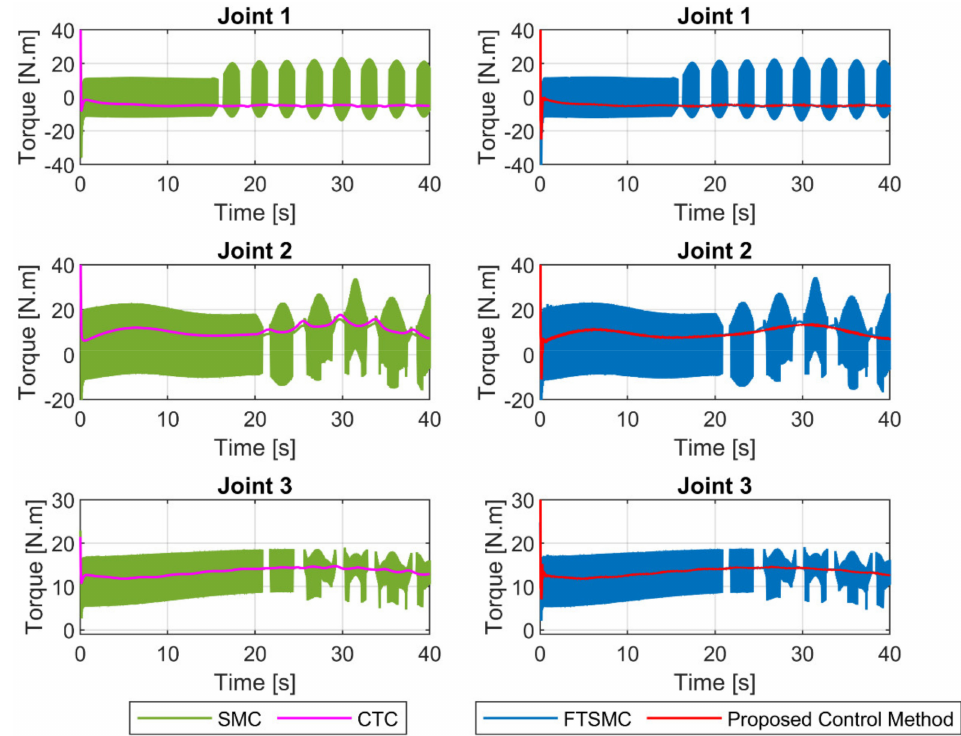
Figure 12. The control input torques at joints under four